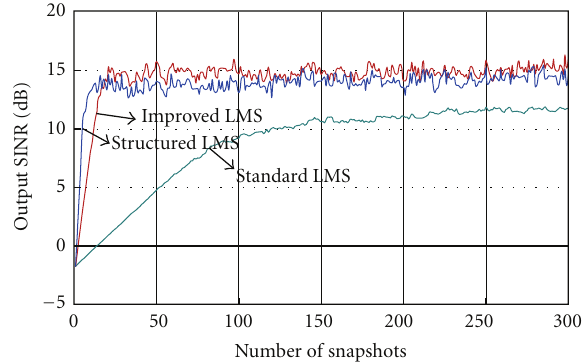
Figure 3: Mean output noise power versus the iteration number. 10 elements, λ /2 spacing, phi = 90 ◦ ; 2 jammers: 72 ◦ , power ratio (p.r.): 100; 98 ◦ , p.r.: